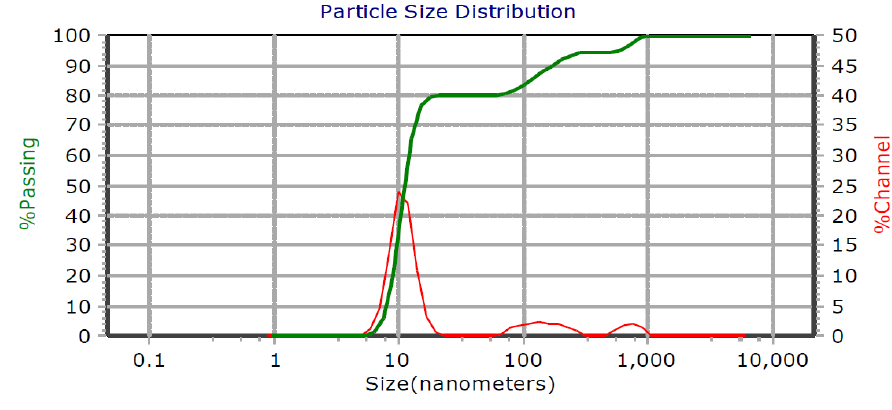
Figure 2. PSA spectrum of T2 NFs.